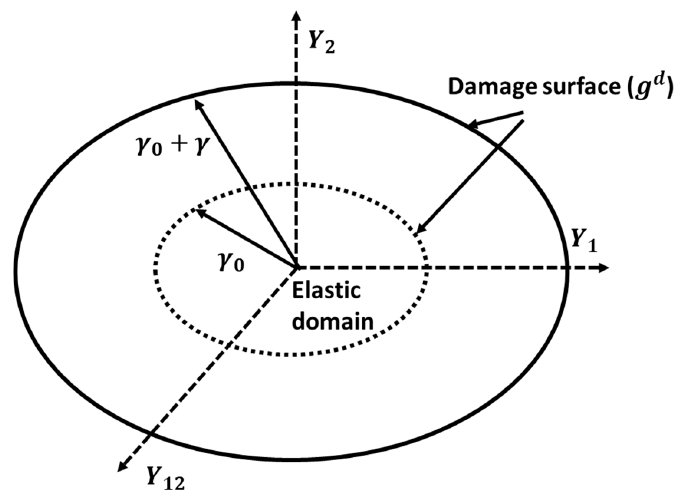
Figure 1. 2D representation of thermodynamic force space where no damage occurs in the elastic domain and the damage surface evolves based on the damage evolution law.